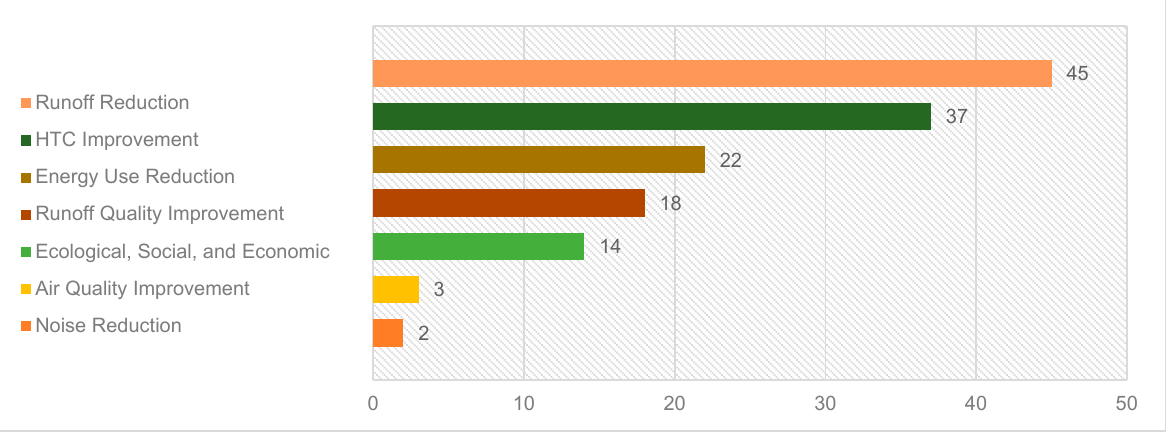
Figure 5. The break-down of papers as per the ecosystem services provided by GRs.